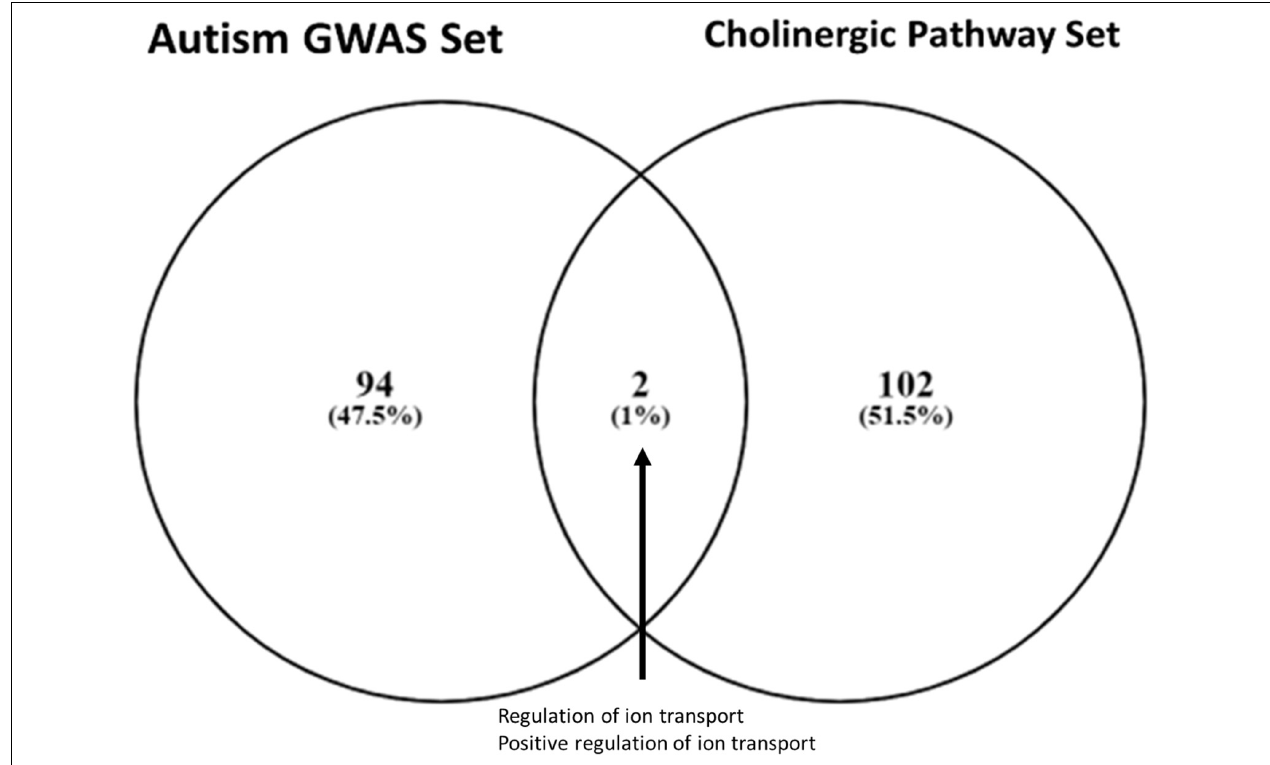
FIGURE 1 | Gene ontology overlap between autism and cholinergic metabolism gene sets. Overlap between an autism-associated genome-wide associated studies gene set (Wu et al., 2020) and cholinergic pathways gene set (MSigDB v7.1) was identified using Venny 2.1. The two shared ontologies were (1) regulation of ion transport and (2) positive regulation of ion transport, identifying ion transport functionality as a critical area of enrichment for further analysis.